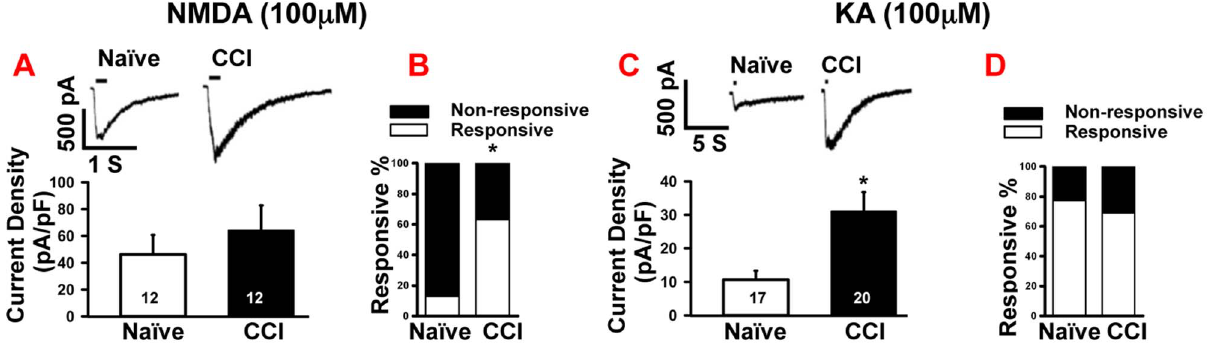
Figure 3. CCI of sciatic nerve increased responses to NMDA and KA in small diameter neurons. A. Upper panel: Puff application of NMDA (100 m M, 200 ms) had no effect on inward currents in small DRG neurons from naı¨ve or CCI rats. Bar indicates the duration of drug application. Lower panel: Statistical analysis showed no differences in inward currents induced by NMDA between CCI and naı¨ve rats. B. Population analysis showed that the percentage of the NMDA-responsive neurons increased after CCI. C. Upper panel: Example of KA-induced (100 m M, 200 ms) increases in inward currents in CCI DRGs. Bar indicates the duration of drug application. Lower panel: Statistical analysis showed that KA induced a significantly larger response in CCI group compared with naı¨ve. D. Population analysis showed that the percentage of the KA-responsive neurons did not change significantly after CCI. Numbers in each column represents recorded neurons. Mean 6 SEM, * p , 0.05.